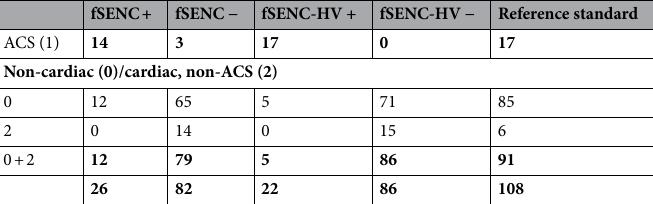
Table 3. Diagnosis according to fSENC at rest and after HVBH as compared to reference standard. Significant values are in